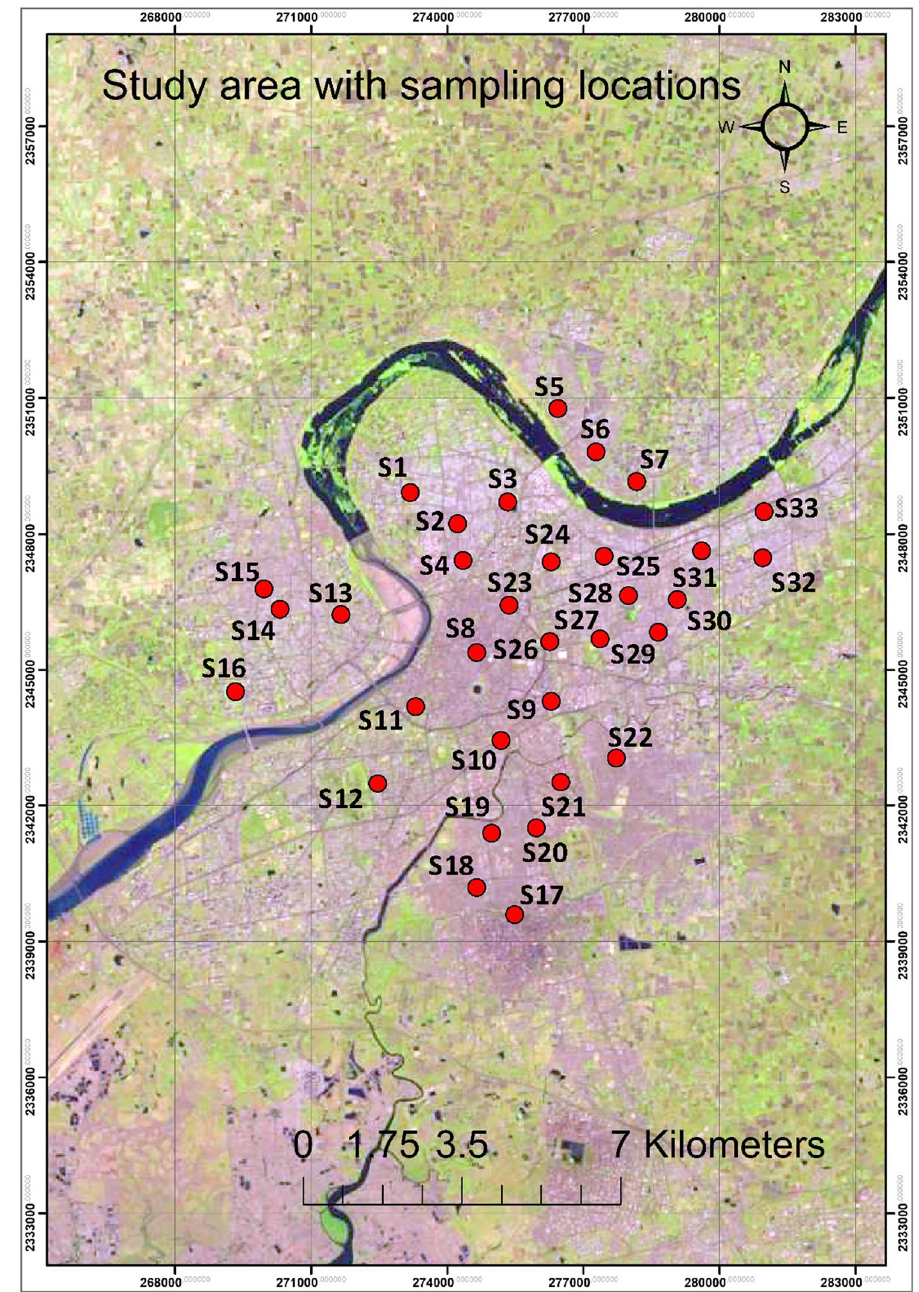
Fig. 2 Study area map with sampling